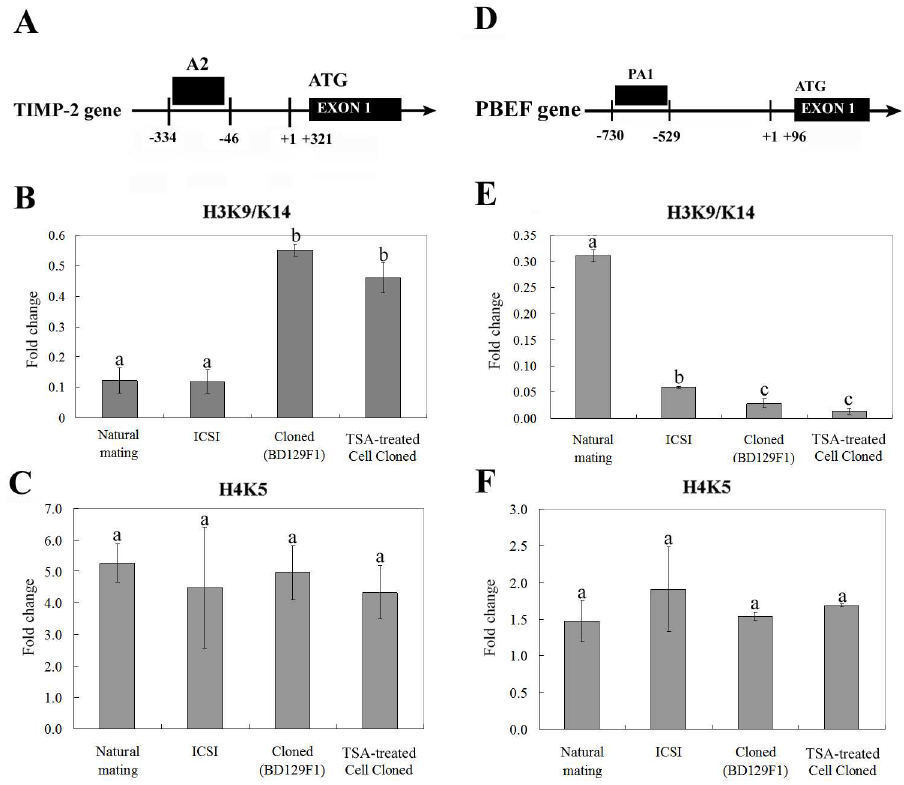
Fig 5. Histone modifications at the TIMP-2 and PBEF promoter regions. (A) Schematic of the TIMP-2 promoterregion. Abbreviations: +1, the transcriptionstart site; and A2, site analyzedfor histone acetylation. (B) H3-K9/K14 acetylationof TIMP-2 in NM control, ICSI-derived, cloned, and TSA-treated cloned placentae. (C) Graph showingthe H4-K5 acetylationstatus of TIMP-2 . (D) Schematic of the PBEF promoter